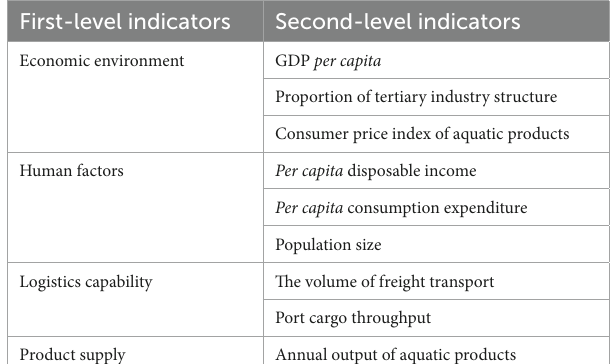
TABLE 2 Indices